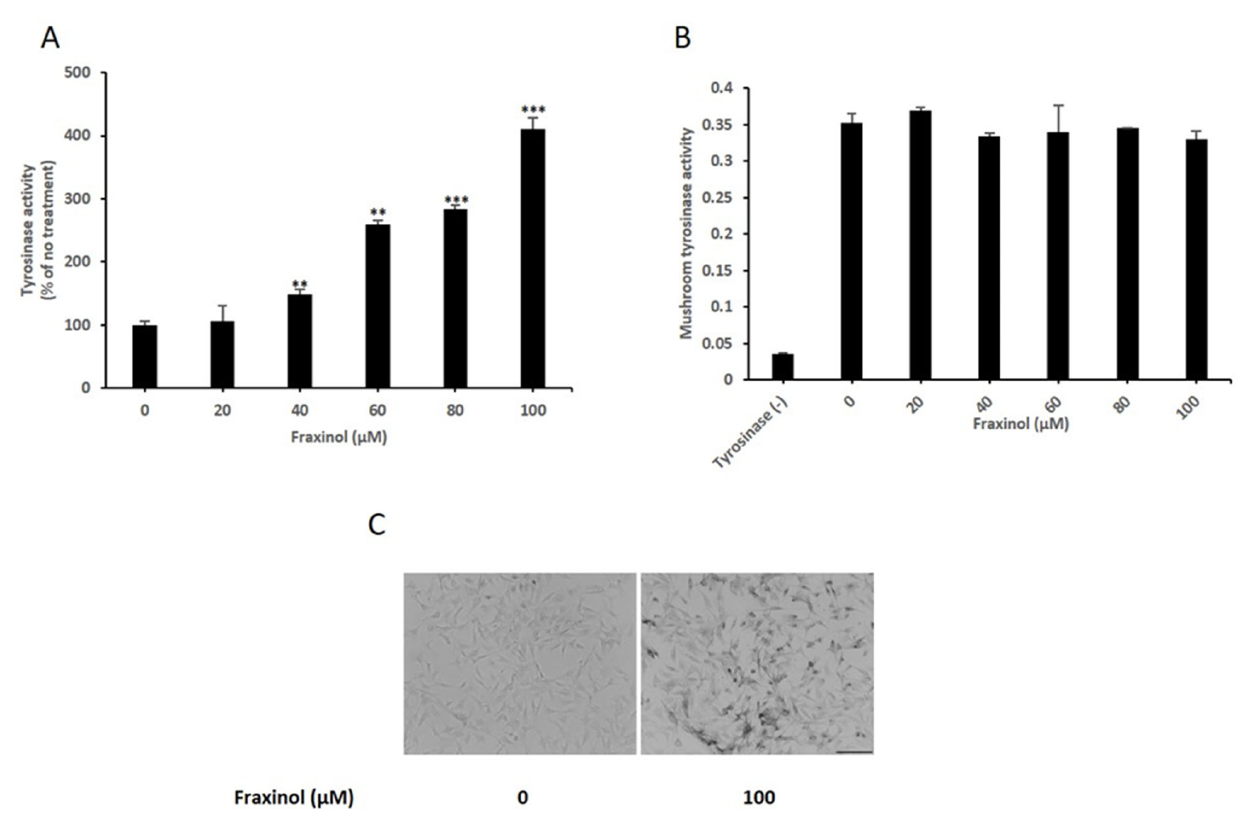
Figure 2. Effects of fraxinol on tyrosinase activity in B16F10 cells. ( A ) B16F10 cells were treated with fraxinol (0, 20, 40, 60, 80, or 100 μ M) for 48 h. The tyrosinase activity is presented as percentages compared to the respective value obtained for the control cells (no treatment). ( B ) Effect of fraxinol on mushroom tyrosinase activity in a cell free system was determined as described in the Material and Methods section. ( C ) Intracellular tyrosinase activity was observed using a light microscope after DOPA staining (scale bar, 100 μ m). The data are presented as the means ± SD; n = 3. ** p < 0.01, *** p < 0.001 compared to 0 μ M (no treatment).